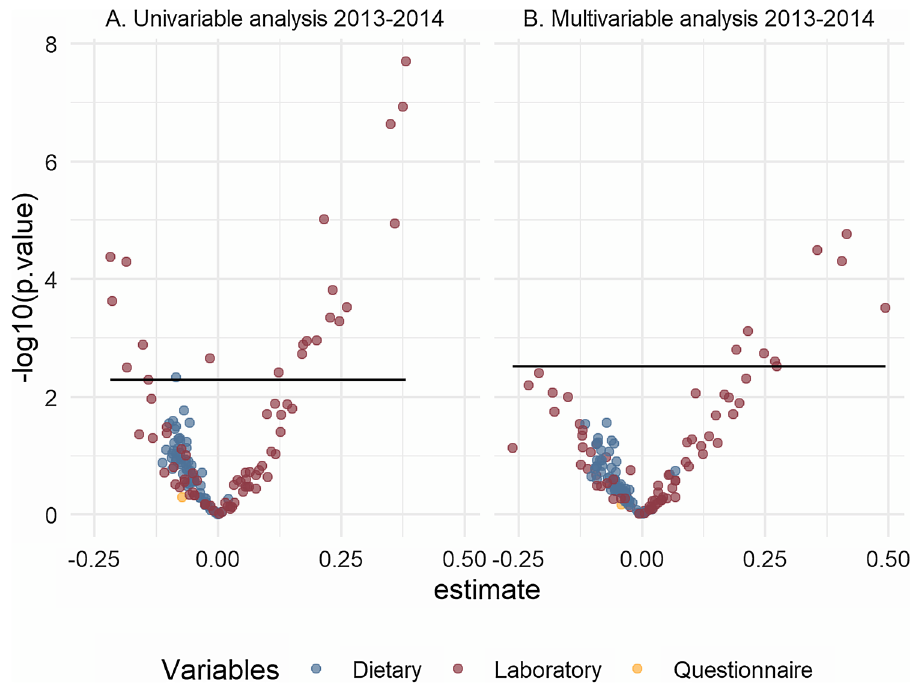
Figure4. Volcano plots for the univariate regression and multivariable regressions in the 2013–2014 dataset.